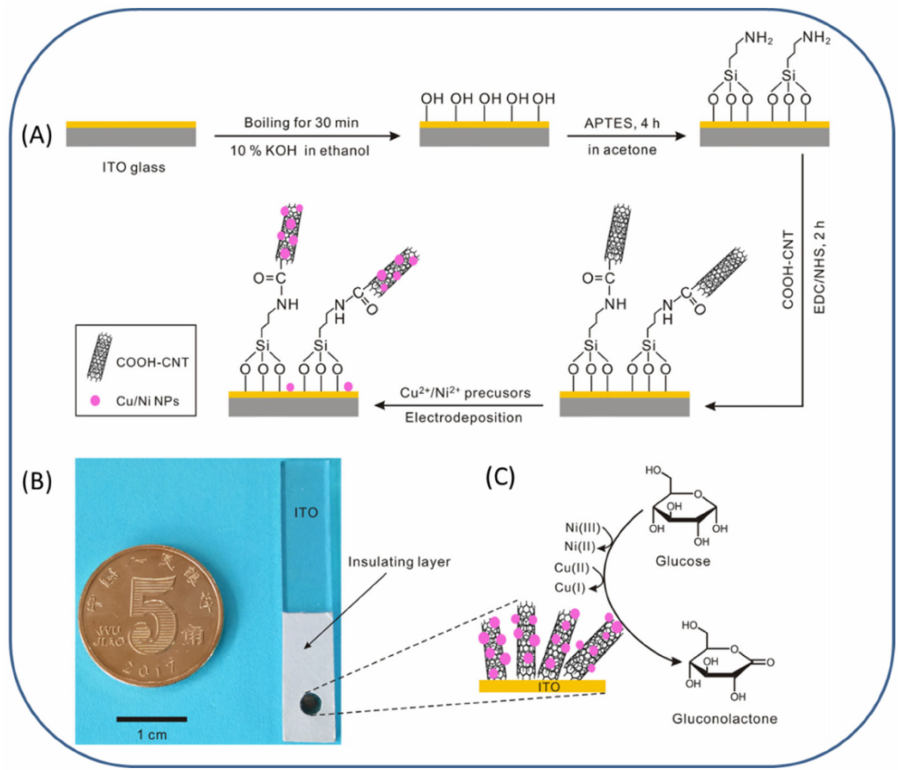
Figure 2. ( A ) Schematic representation showing the preparation of a Cu/Ni NPs CMWCNTs catalyst at the ITO substrate; ( B ) photograph of the as-prepared glucose electrochemical sensor. The total size of the sensor was 4 cm-length × 0.7 cm-width, revealing a 3 mm-diameter area for nanocatalyst assembly; ( C ) schematic illustration of the electrochemical reaction of glucose on the interface of Cu/Ni-CMWCNTs composite. Reproduced with permission from Ref.